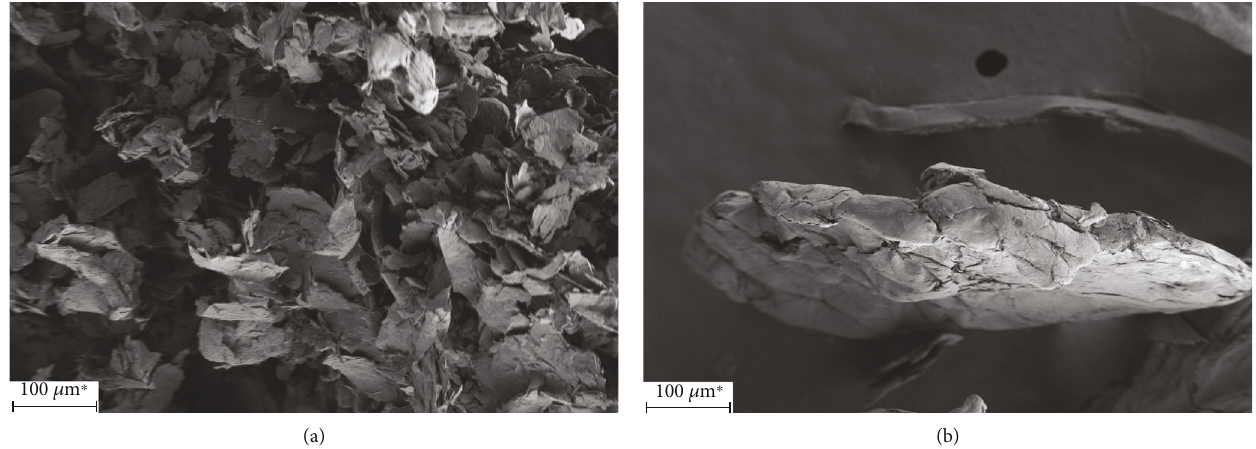
Figure 1: SEM micrograph of EG5 ((a) magni fi cation 5,000x) and EG1000 ((b) magni fi cation 5,000x).